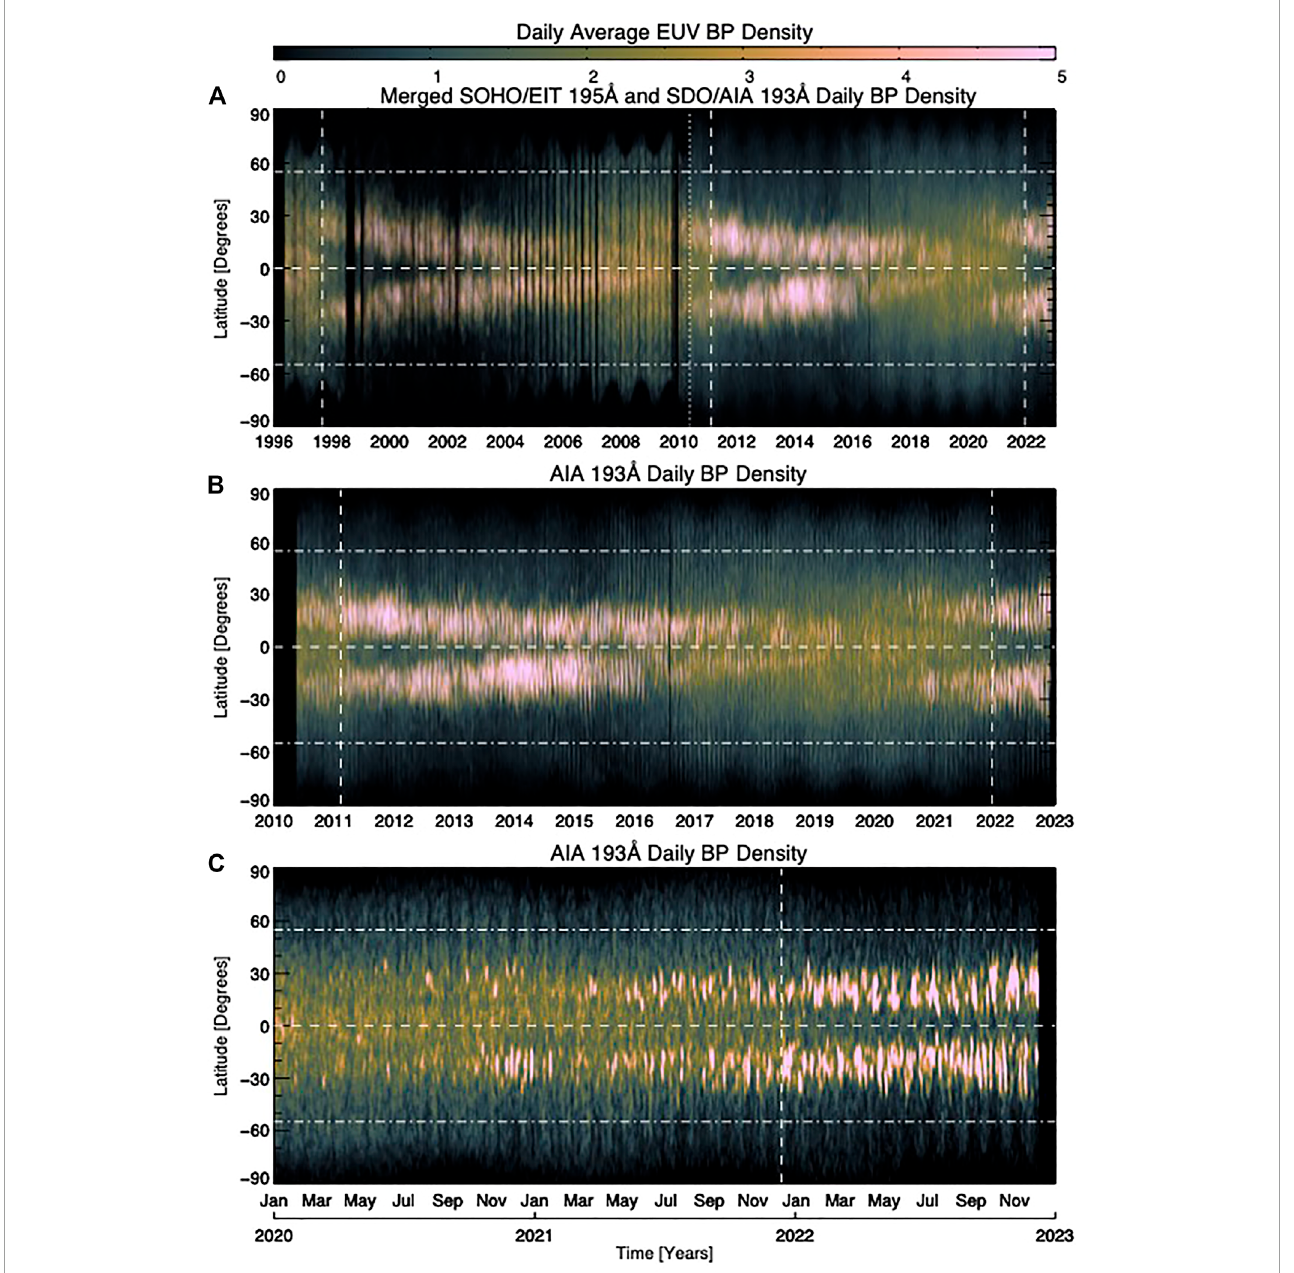
FIGURE 2 Comparing the daily latitudinal variation (latitude versus time) within 5° of the Sun’s central meridian of EUV BPs over three epochs. Panel (A) shows the BP density variation from 1996 to the present combining observations from SOHO/EIT (in 195Å) and SDO/AIA (in 193Å) - note the three white vertical dashed lines present that signify the occurrence of a terminator during this epoch. Panel (B) shows the BP variation since the start of the SDO mission (2010) to the present (in 193Å), where the two vertical dashed lines signify terminator taking place in this epoch. Panel (C) zooms in to show the BP variation since the start of the 2020 to the present (in 193Å), and the single vertical dashed signifies the most recent terminator. Each panel shows a horizontal line to indicate the position of the equator and dot-dashed lines at ± 55°.